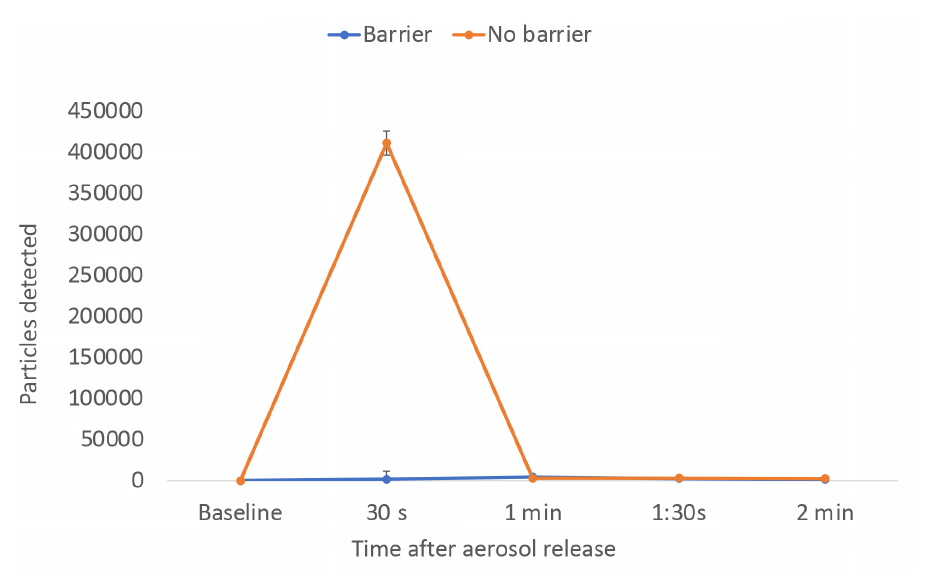
Figure 2A. Effective